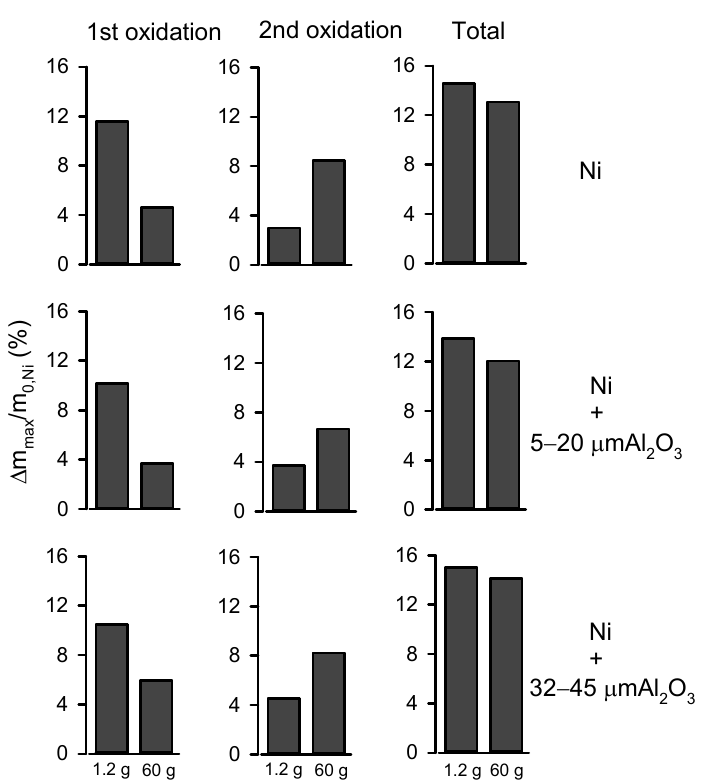
Figure 5. Effects of sample weight on maximum weight gain of samples after the first and second oxidation cycles and a summary after two oxidation cycles.